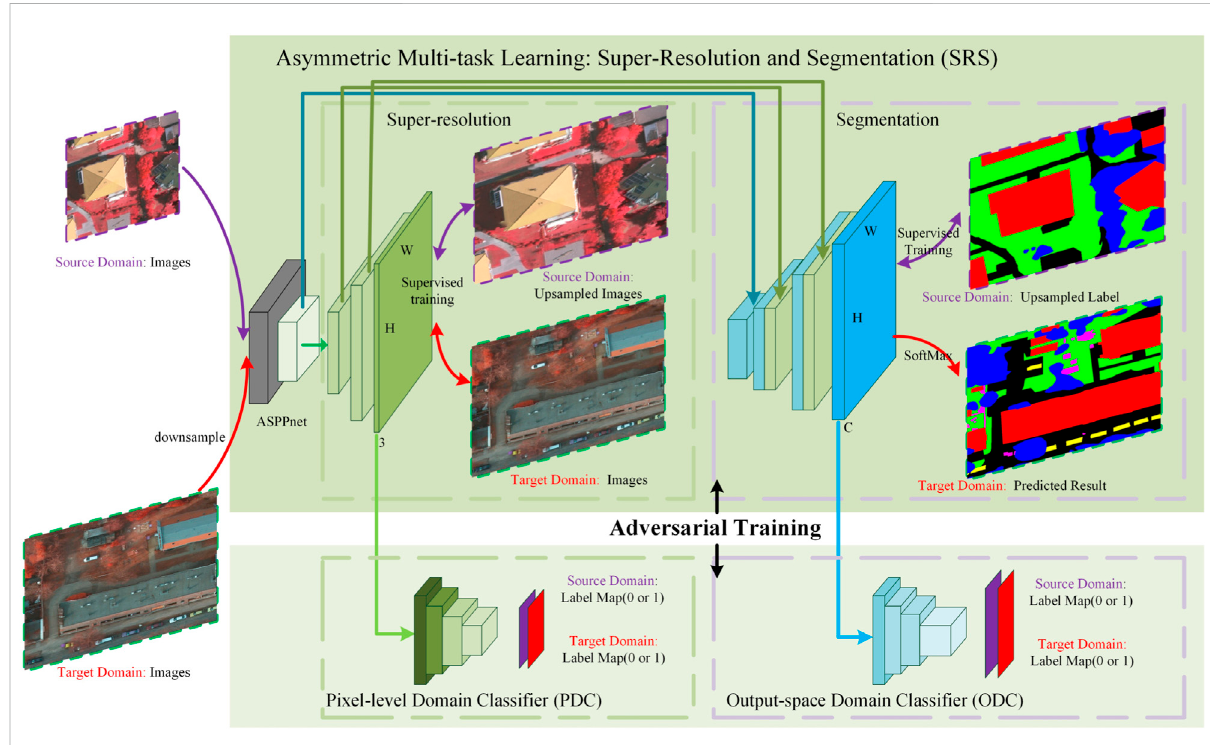
FIGURE 2 Overview of the proposed Super-Resolution Domain Adaptation Network (SRDA-Net). The two models, super-resolution model and the segmentation model, are integrated together based on asymmetric multi-task learning, as presented in the upper part. At the stage of training, two images randomly selected from source domain and target domain, respectively, are input into the SRS model. The purple and red curves, respectively,indicatetheinput/outputofthesourceandtargetdomains,and,thetwo-wayarrowindicatesthedata fl owinvolvedinthetraining process.Notethatsourceimagesareusedfortrainingthesuper-resolutionmodelandsegmentationmodelinthesupervisedmode,whilethetarget images only participate the super-resolution training. The two domain classi fi ers, PDC and ODC, are displayed in left and right bottom parts, respectively.Thesuper-resolutionimagesfromSRSarefedintoPDC,andthepredictedlabeldistributionsfromSRSarefedintoODC.TheSRScanbe optimized byadversariallytraining SRS andthetwoclassi fi ers.Inthetestingstage,thedownsampledtestimages areinputinto theSRS forpredicting the segmentation